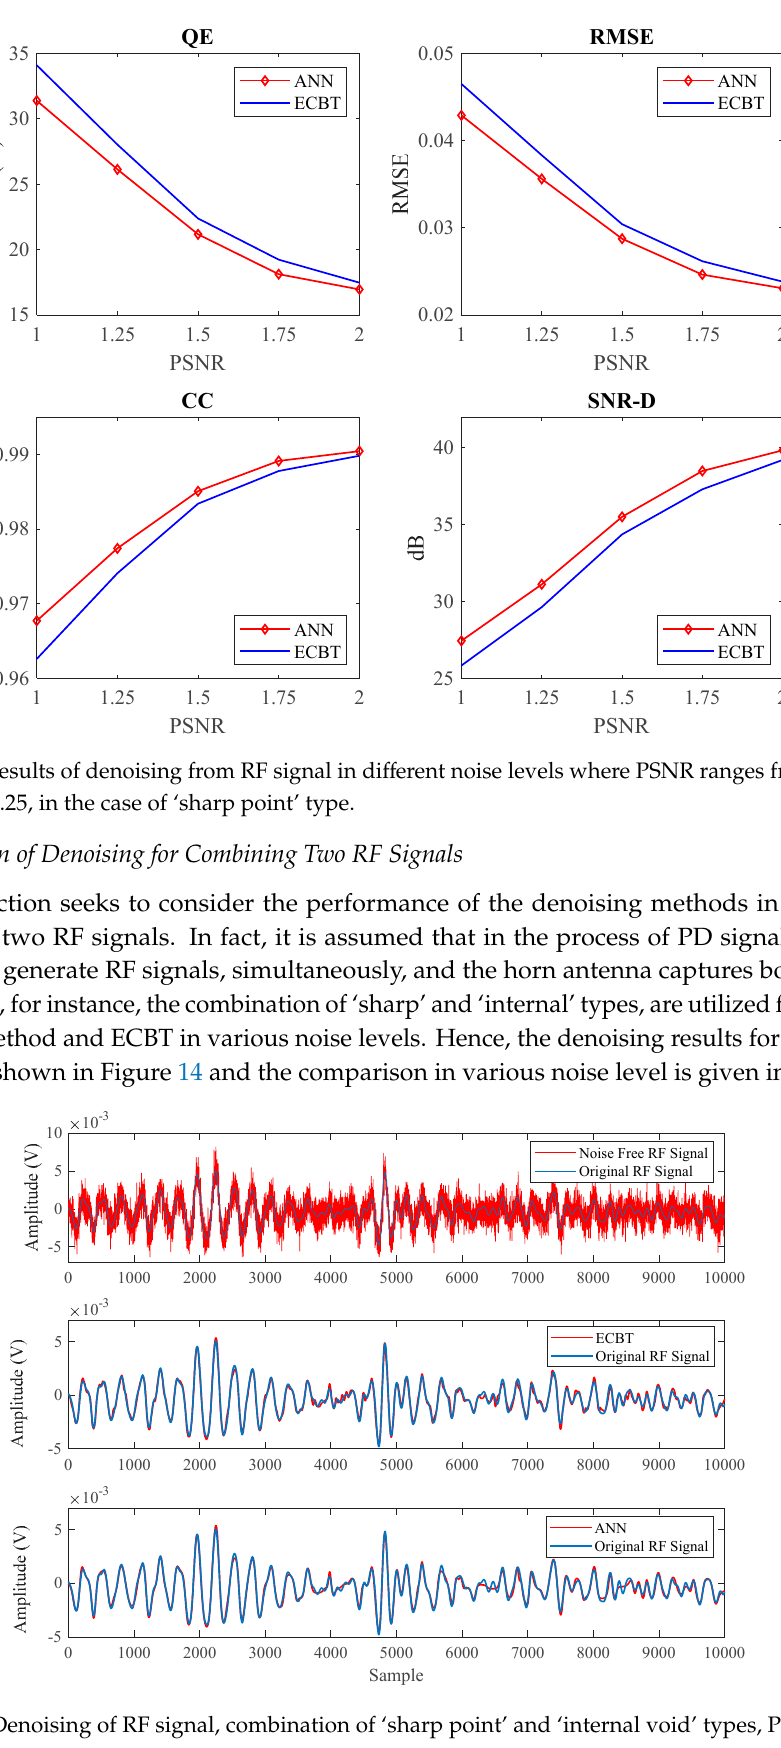
Figure 12. Results of denoising from RF signal in different noise levels where PSNR ranges from 1 to 2 by steps of 0.25, in the case of ‘internal void’ type.